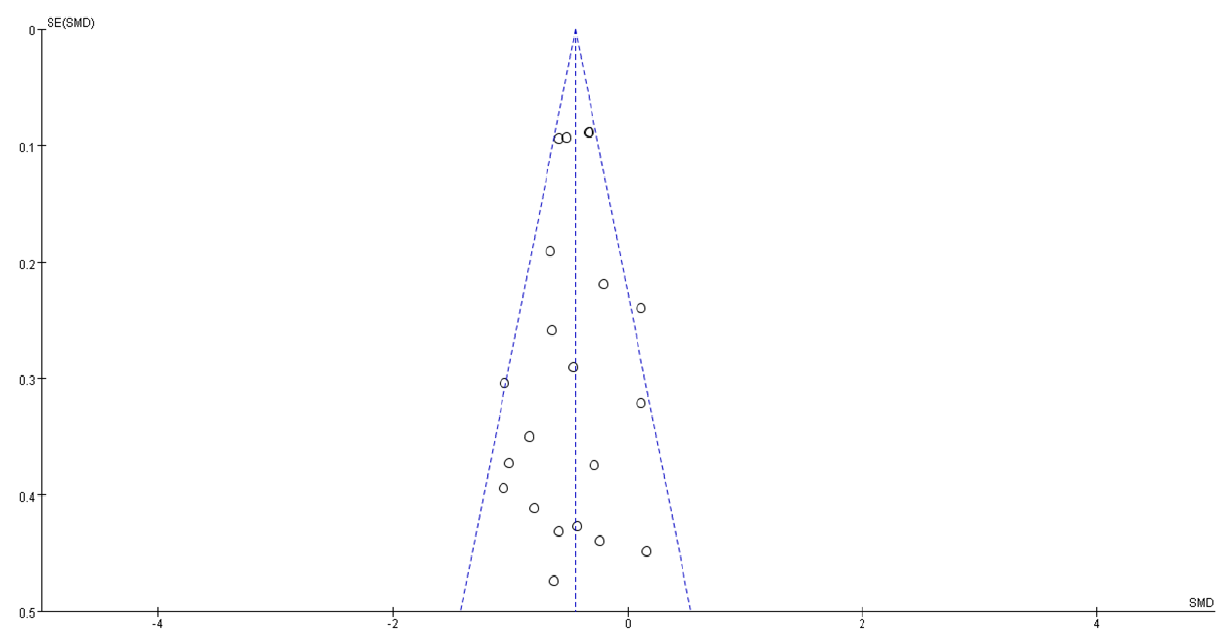
Figure 9. Funnel plot of publication bias. Open circles suggested included studies and diamond explained observed effect size.